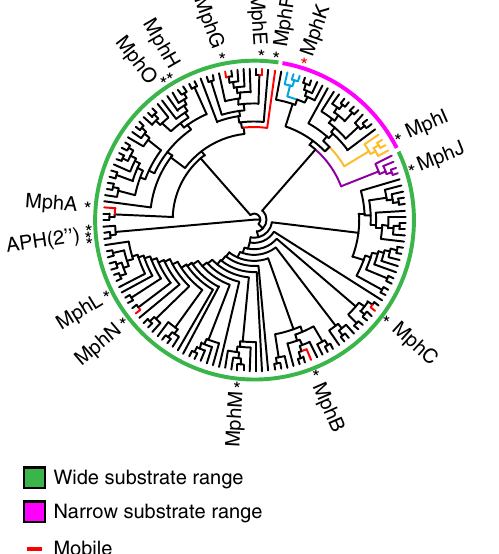
Fig. 2 Phylogenetic reconstruction of macrolide phosphotransferases. Colored bars represent predicted substrate speci fi city based on phylogenetic clustering of known Mphs and their homologs. Asterisks represent experimentally validated Mphs, and the red asterisk represents MphK, which was identi fi ed from this analysis as a Mph that does not confer C3 cladinose macrolide resistance. Colored portions of the phylogenetic tree highlight clusters of interest. Mphs captured on mobile genetic elements are colored red. The tree is presented as a cladogram, and the root drawn with GTP-dependent APH(2 ” ) enzymes as outgroups. A cladogram with complete labels and bootstrap values can be found in